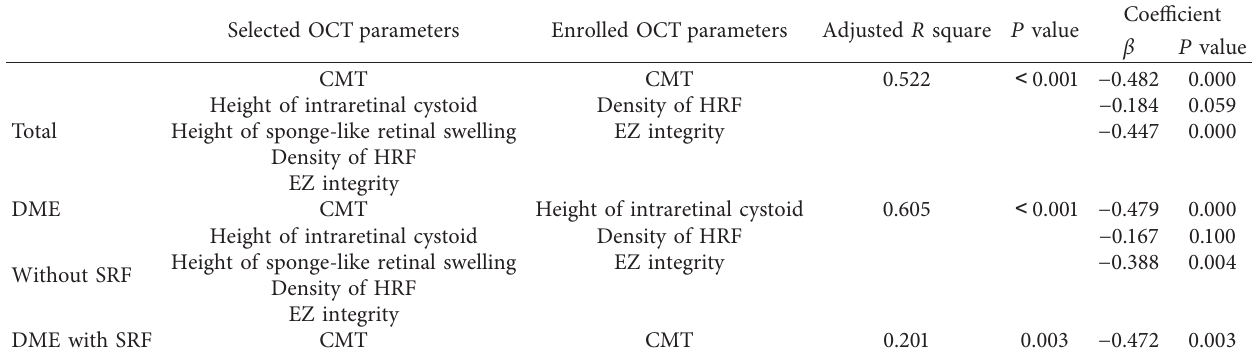
Table 3: Results of multivariate linear regression analysis in different subgroups.